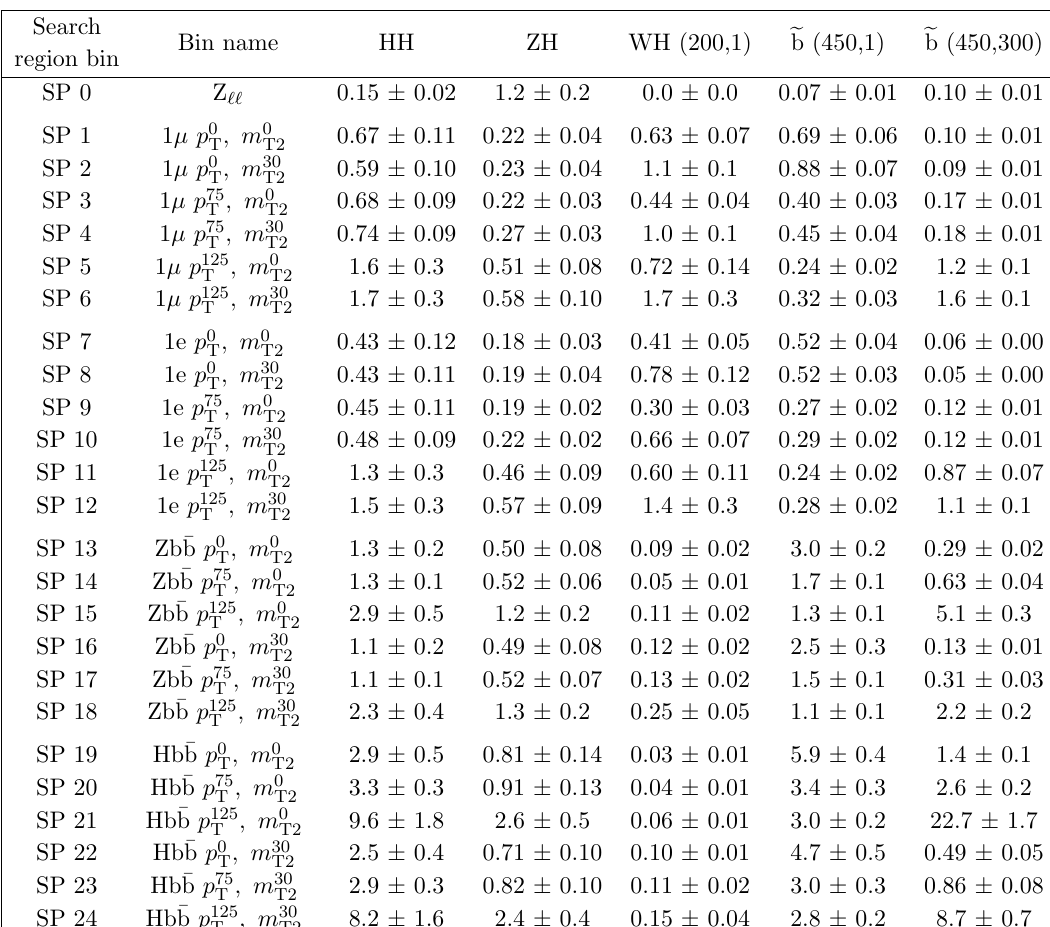
Table 8 . The expected signal yields for the SUSY simpli(cid:12)ed model signals considered are shown for each search region bin in the Hb(cid:22)b, Zb(cid:22)b, and leptonic categories of the SP analysis. The bin names give a short-form description of the search region bin de(cid:12)nition which are given in full in table 2. The labels p 0 , p 75 , and p 125 refer to bins de(cid:12)ned by the requirement that p (cid:13)(cid:13) T T T 0.6, between 0.6 and 1.0, and greater than 1.0, respectively. The labels m 0 de(cid:12)ned by the requirement that m T2 is less than and greater than 30 GeV, respectively. The labels HH and ZH refer to the signal models for higgsino-like chargino and neutralino production where the branching fractions of the